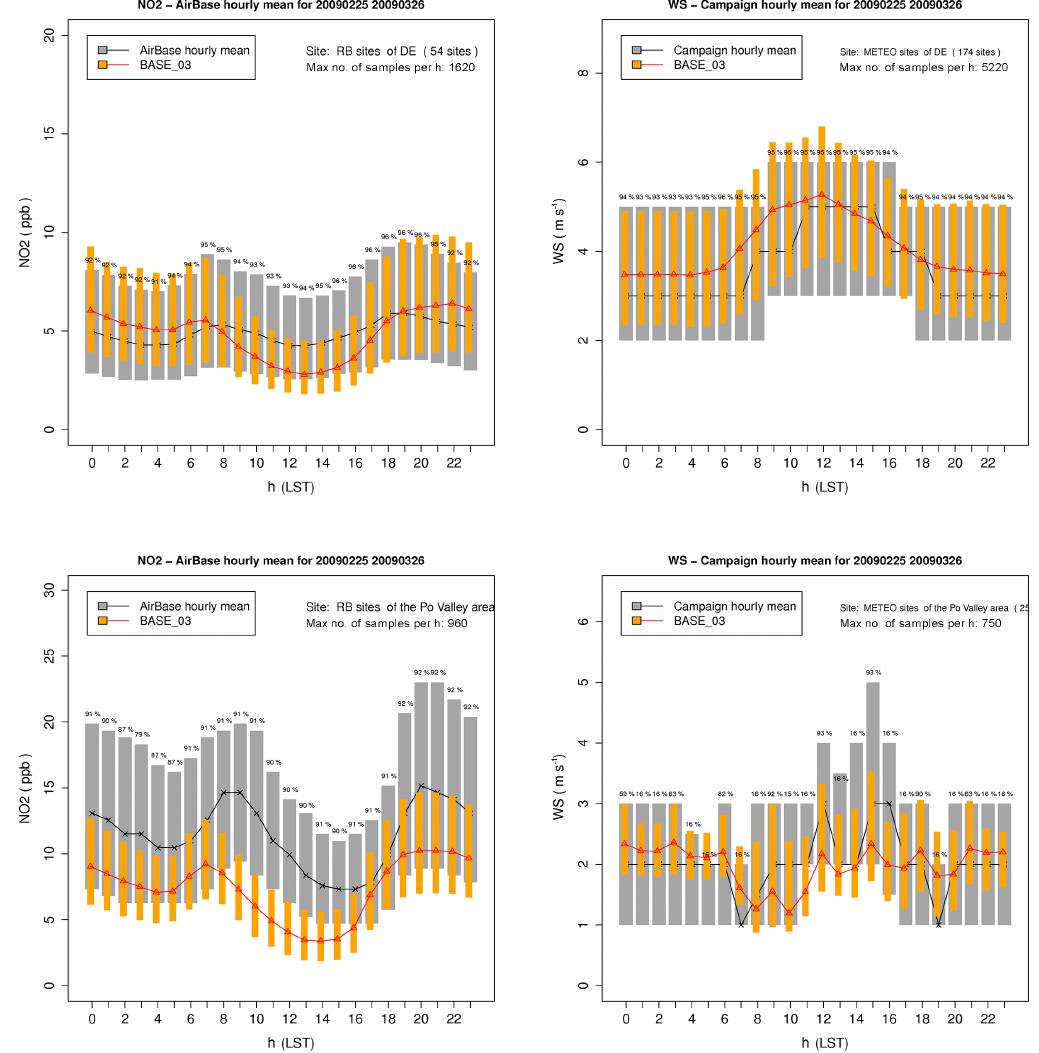
Figure 20. Time series of hourly box plots showing the distribution of the diurnal cycle observed and computed NO 2 concentration (left) and wind speed (right) over Germany (top panels) and Po Valley (bottom panels). Observations are in black/grey; modelled values in red/orange. Bars show the 25–75th quantile interval, while the median is displayed by the continuous line. The 25, 50, 75 and 95th quantiles of the whole campaign are reported, too. Comparison of computed and observed box plot time series evaluated at AirBase and meteorological sites, available over Germany and Po Valley. Time is indicated in UTC